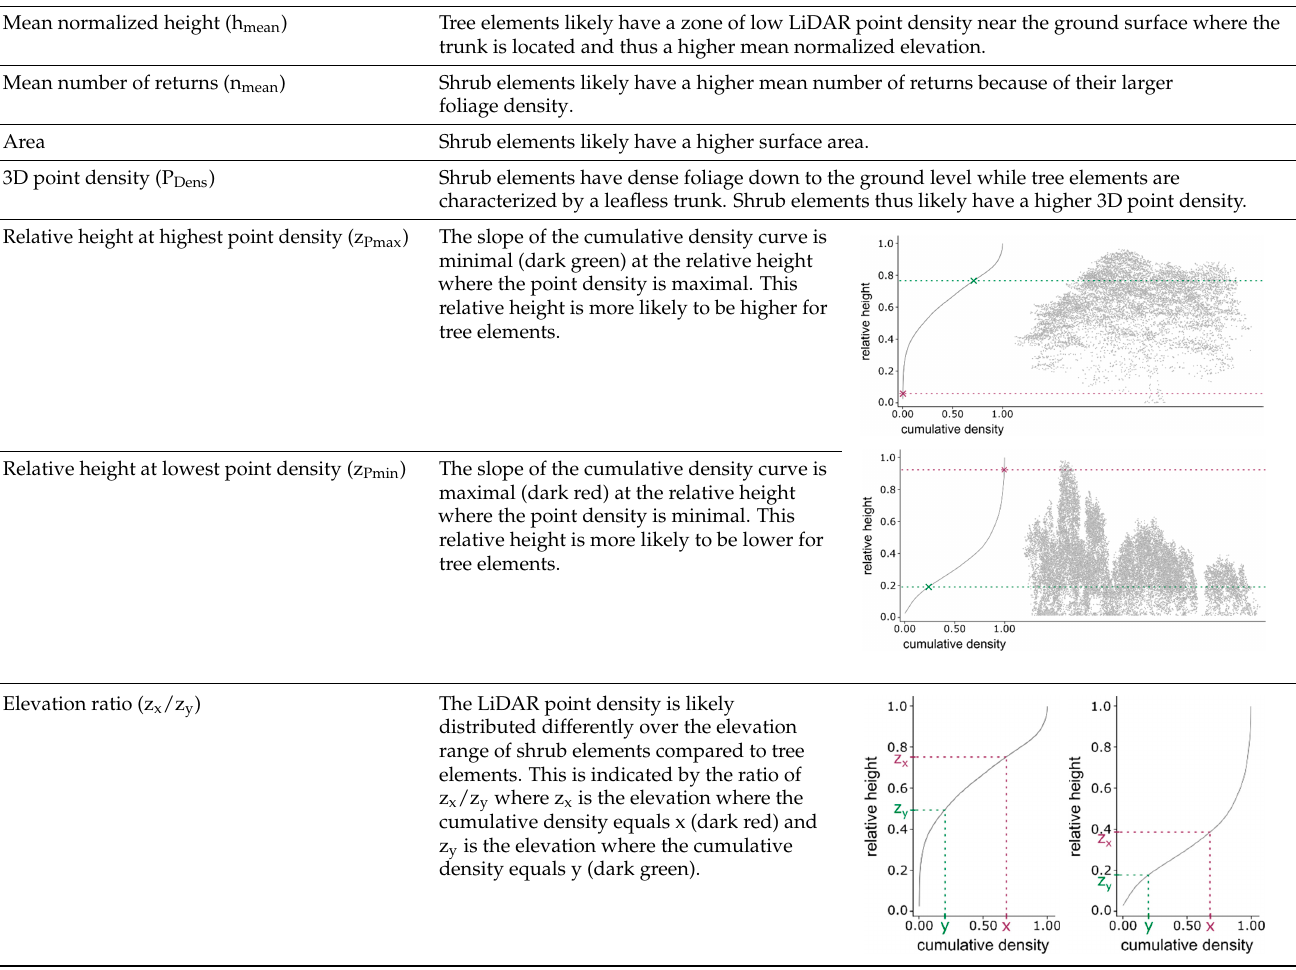
Table 4. Candidate features for the classification of the 2D vLE objects and justification for their consideration. Predictor Variable